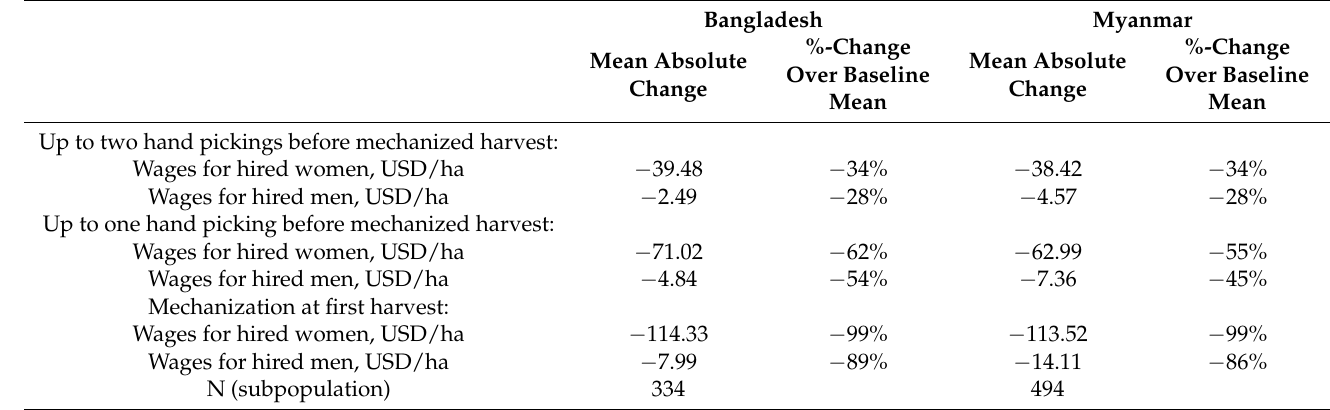
Table 6. Estimated wage reduction with